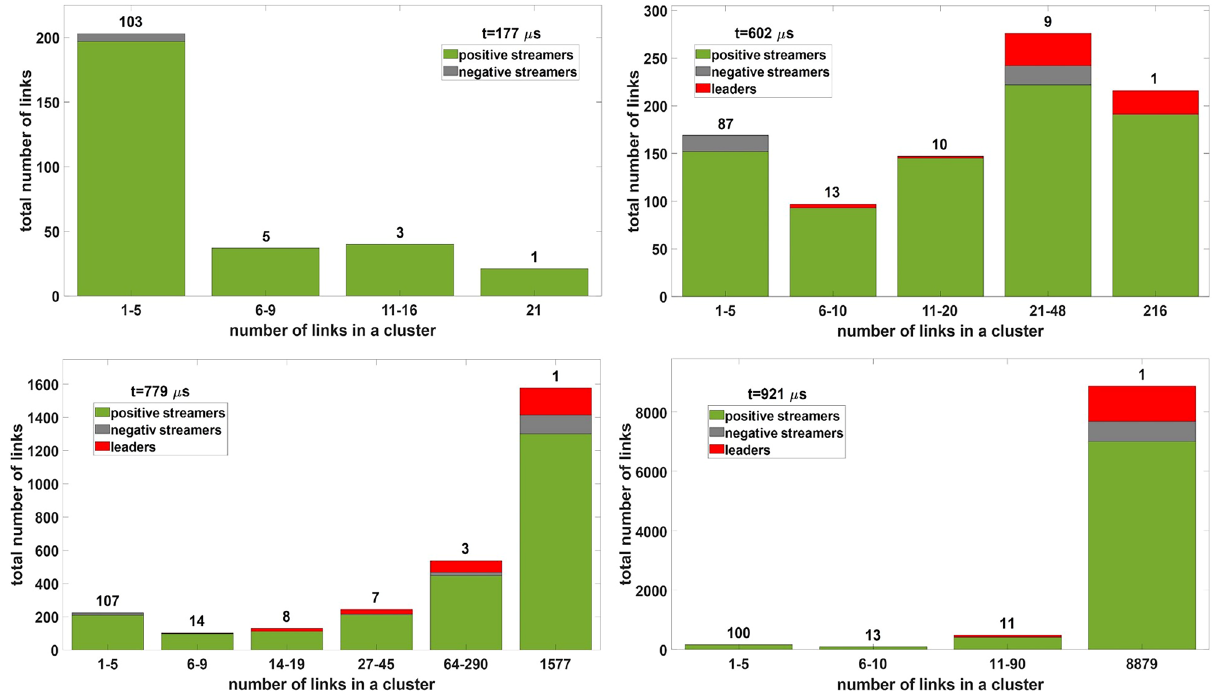
Figure 14. Distributions of model links by clusters of different sizes at four moments of time corresponding to panels ( a–d ) in Fig. 10. Except the most widespread positive streamers (green color), each bar may include some amount of negative streamers (grey color) and/or leaders (red color). Numbers at the tops of each bar denote amounts of clusters with the quantities of links shown on the horizontal axis. In each panel the biggest cluster is shown on the